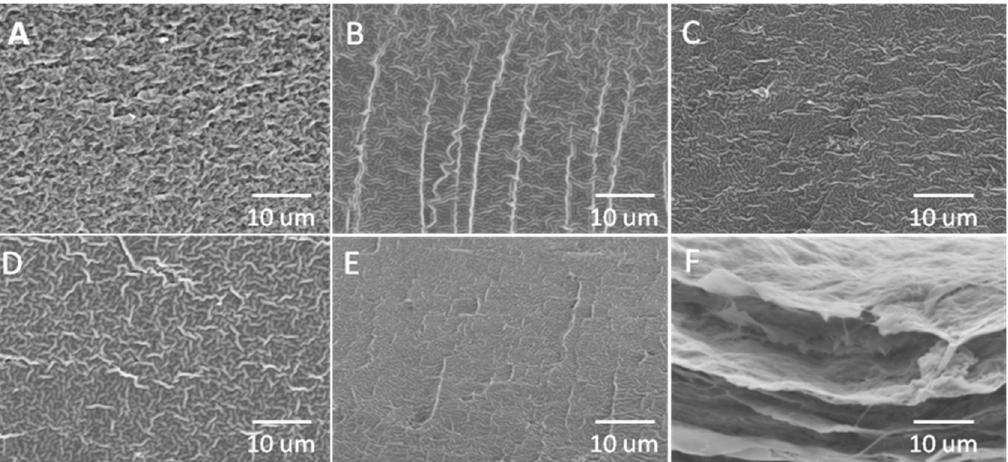
Figure 2. Fractured cross-sectional image of C ( A ), CB ( B ), CB-b ( C ), CB-t ( D ), CB-bt ( E ), and bacterial cellulose film imaged by SEM.